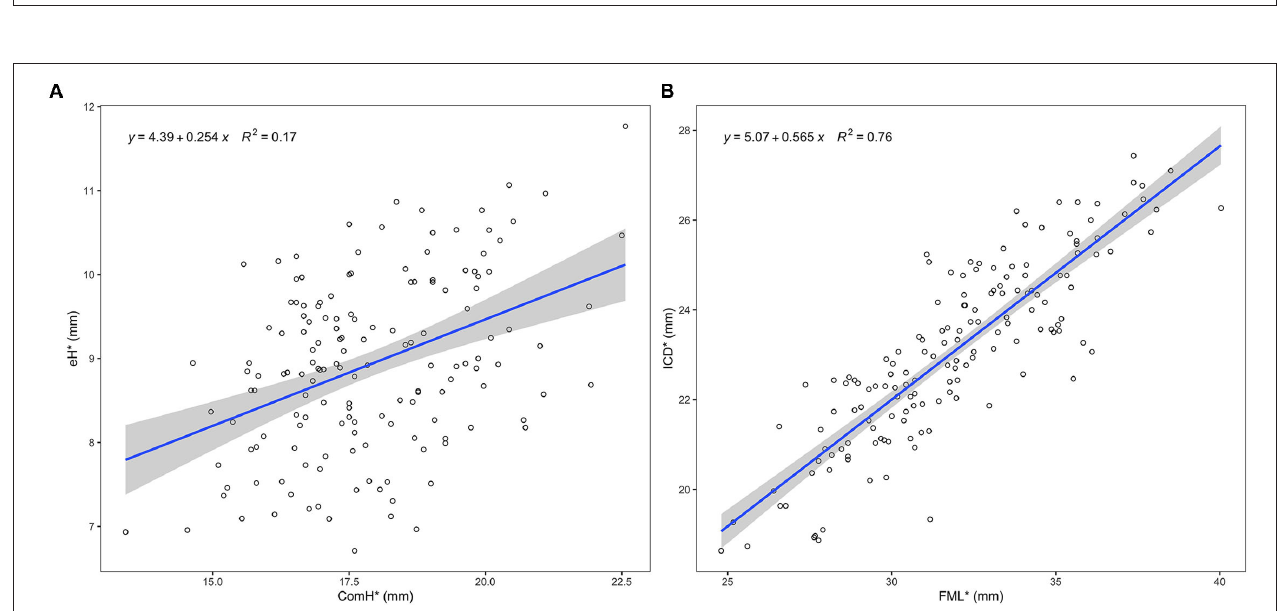
FIGURE 3 | Relationship between specific leaflet and root measures. The blue line represents the best fit linear regression model of the data points. The shaded gray area represents the 95% confidence level interval for predictions from each linear model. (A) Linear regression between ComH and eH. (B) Linear regression between FML and ICD. eH, effective height; ComH, commissural height; FML, free margin length; ICD, inter-commissural distance; *, average measures of three leaflets.